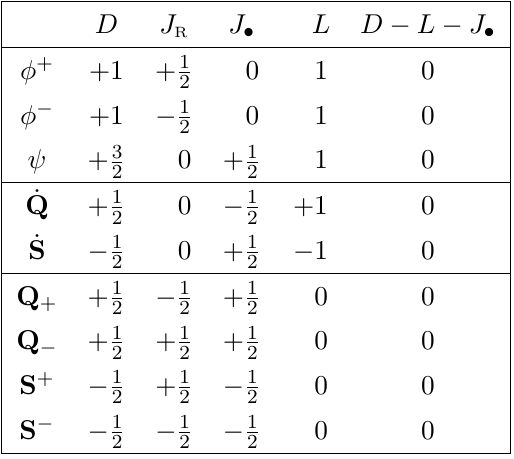
⊕ su(1 | 2) subsector. L R